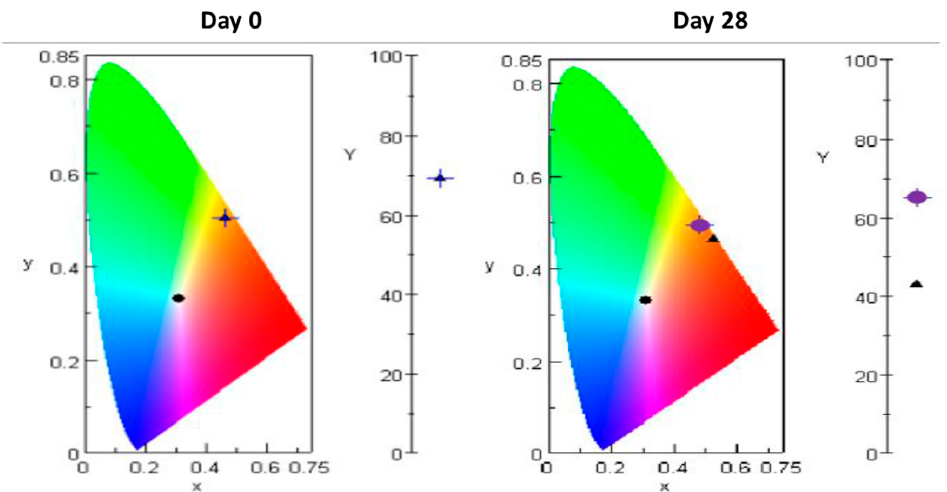
Figure 6. Chromaticity (xy diagram) and luminance (Y) results of the HP- γ -CD amphotericin B formulation containing 0.5 mg/mL ascorbic acid at day 0 and day 28. Blue cross: day 0 results. Purple formulation containing 0.5 mg / mL ascorbic acid at day 0 and day 28. Blue cross: day 0 results. Purple cross target: storage at 5 °C. Black triangle: storage at 25 °C. cross target: storage at 5 ◦ C. Black triangle: storage at 25 ◦